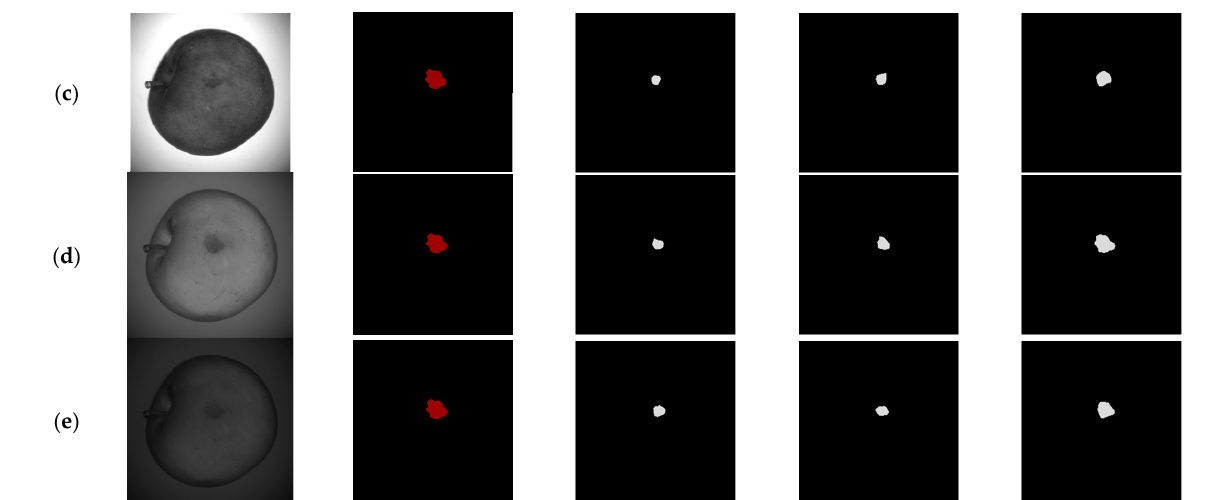
Figure 13. Single-band image, manual extraction of the defects with unobvious features, and algorithmic extraction of the defects with unobvious features: ( a ) 460 nm ( b ) 522 nm ( c ) 660 nm ( d ) 762 nm ( e ) 842 nm.